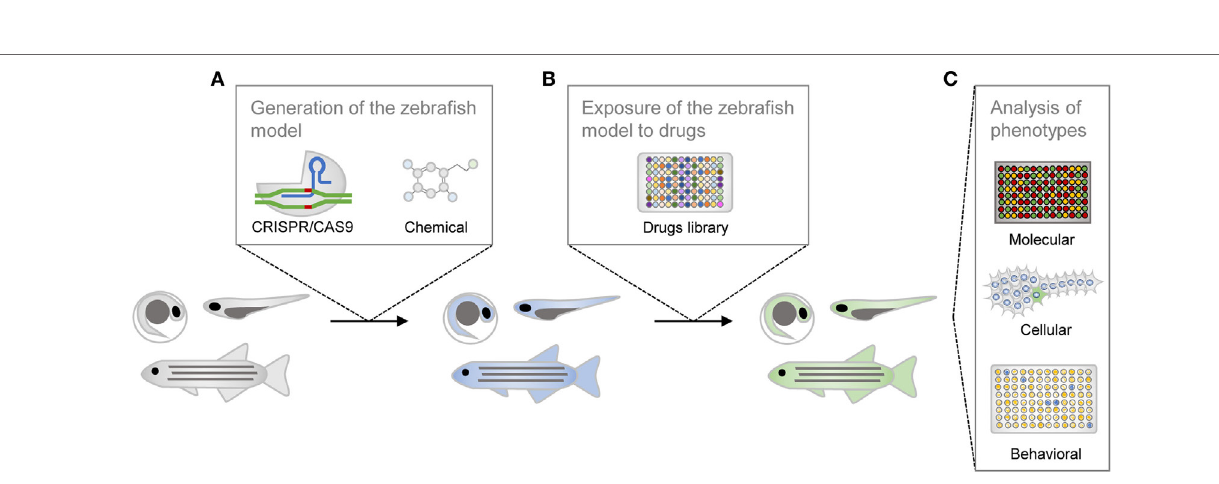
FiguRe 2 | Timeline of the use of zebrafish as a model for the study of movement disorders and drug discovery. The publication year of the first study describing a zebrafish model of the movement disorder is highlighted. (#) Number of studies published to